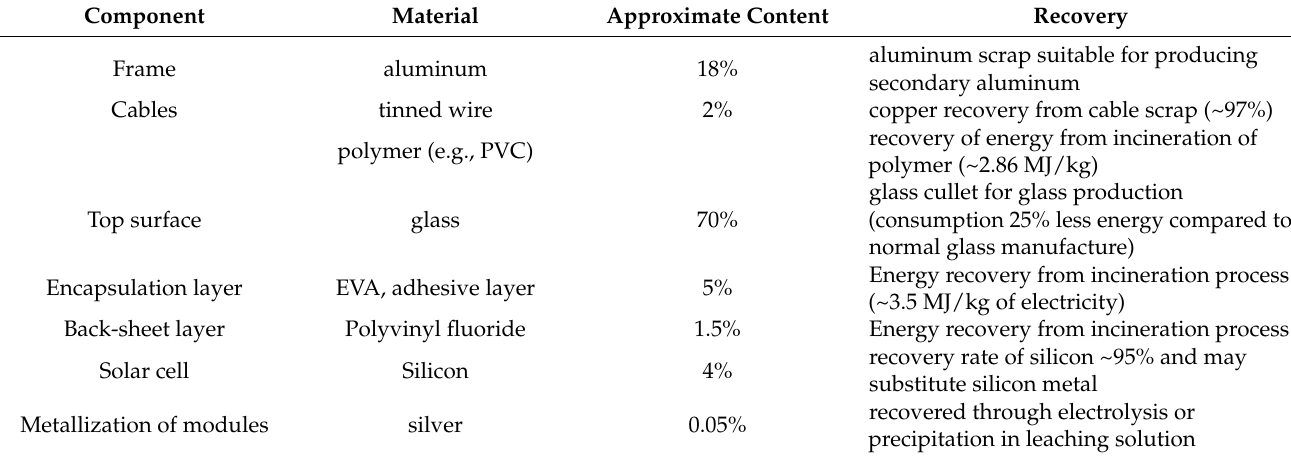
aluminum scrap suitable for producing secondary aluminum recovery of energy from incineration of polymer (~2.86 MJ/kg) glass cullet for glass production recovery rate of silicon ~95% and may substitute silicon metal recovered through electrolysis or precipitation in leaching